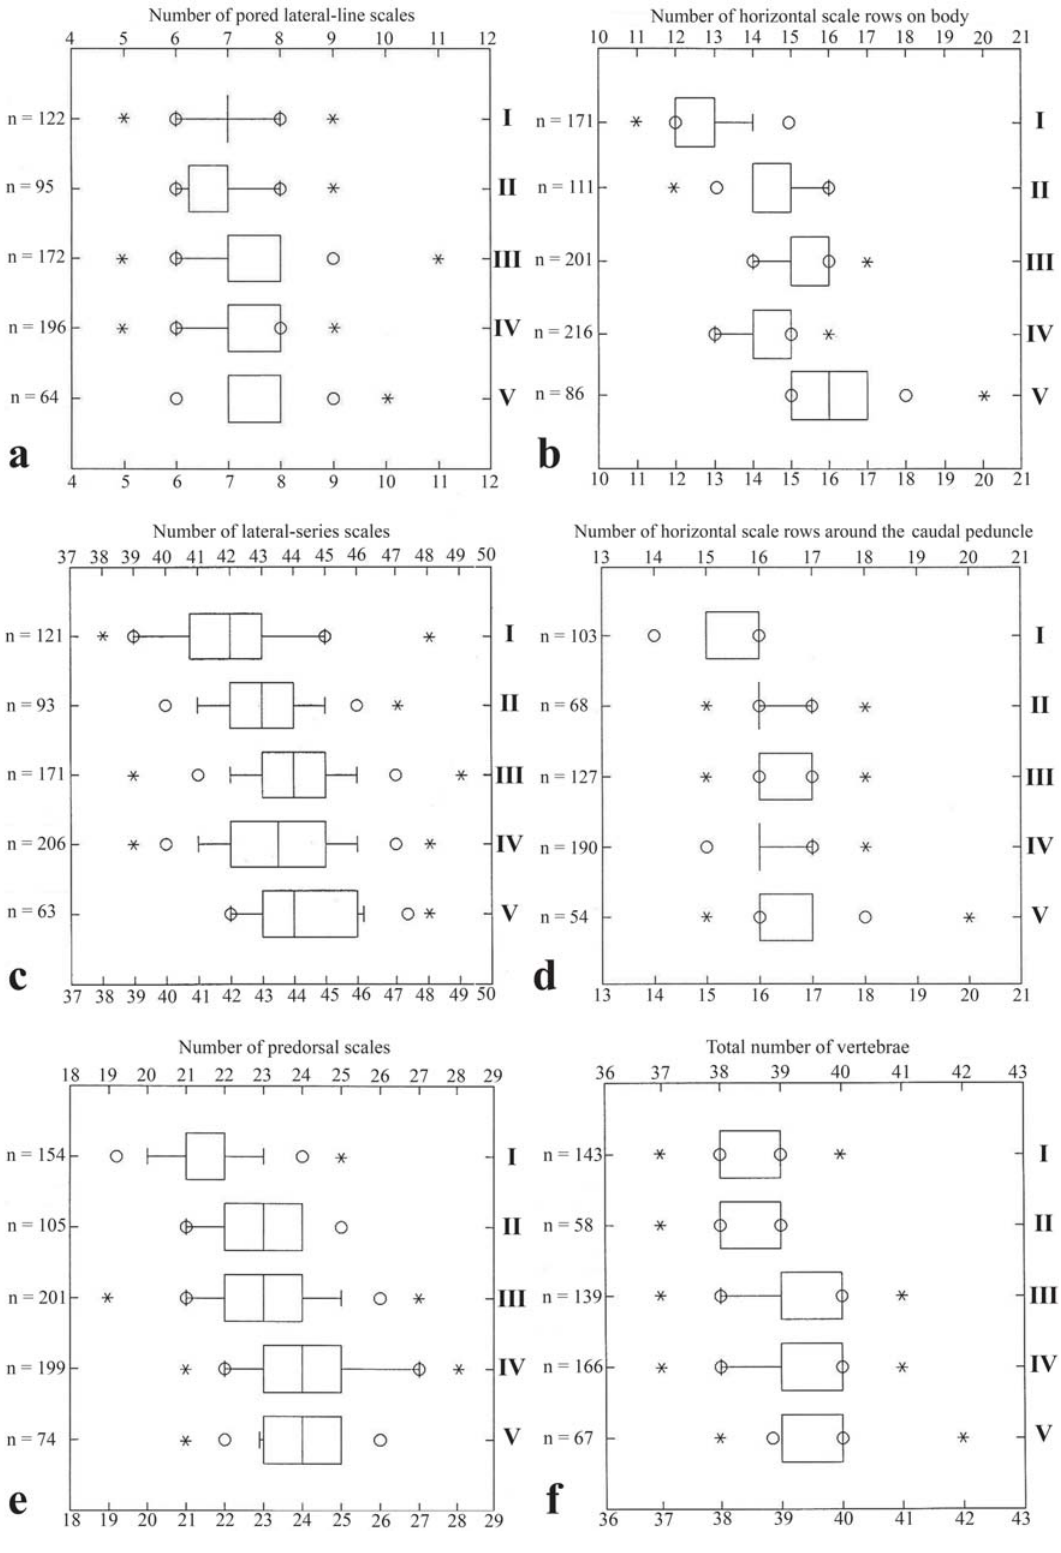
Fig. 90. Comparative plots of (a) Number of pored lateral-line scales; (b) Number of horizontal scale rows on body; (c) Number of lateral-series scales; (d) Number of horizontal scale rows around the caudal peduncle; (e) Number of predorsal scales; (f) Total number of vertebrae for samples of Mimagoniates microlepis within range of species expressed by Tukey box plots. For I, II, III, IV and V locations, see full legends at Fig.